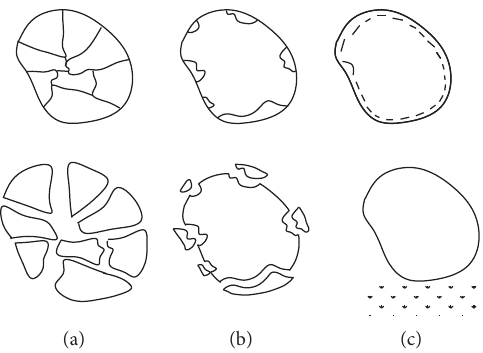
Figure 3: Particle breakage types. (a) Fracture. (b) Broken. (c)